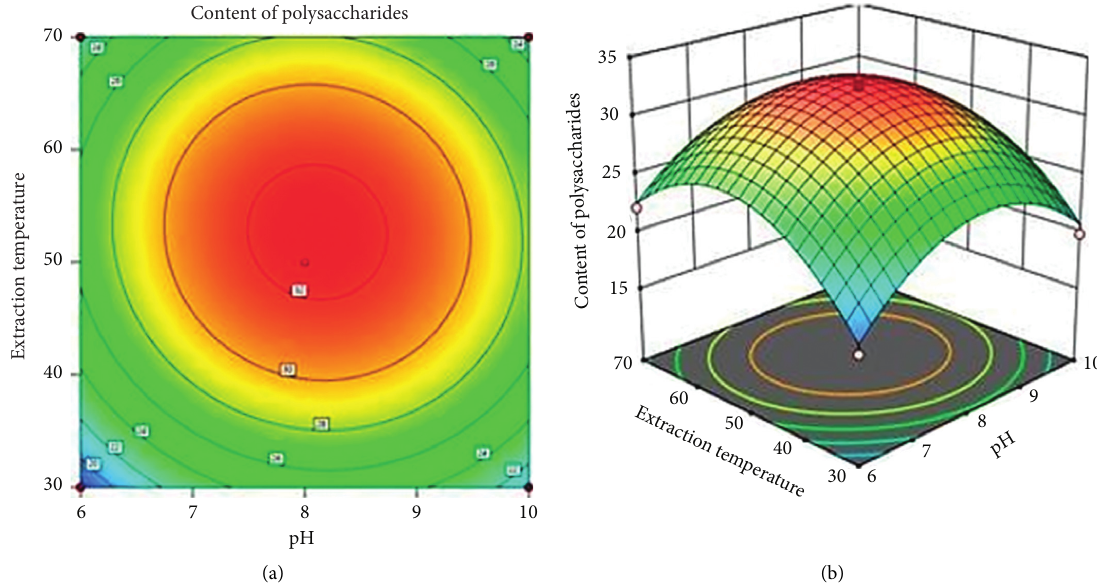
Figure 2: Simultaneous effect of pH and extraction temperature on the content of polysaccharides.